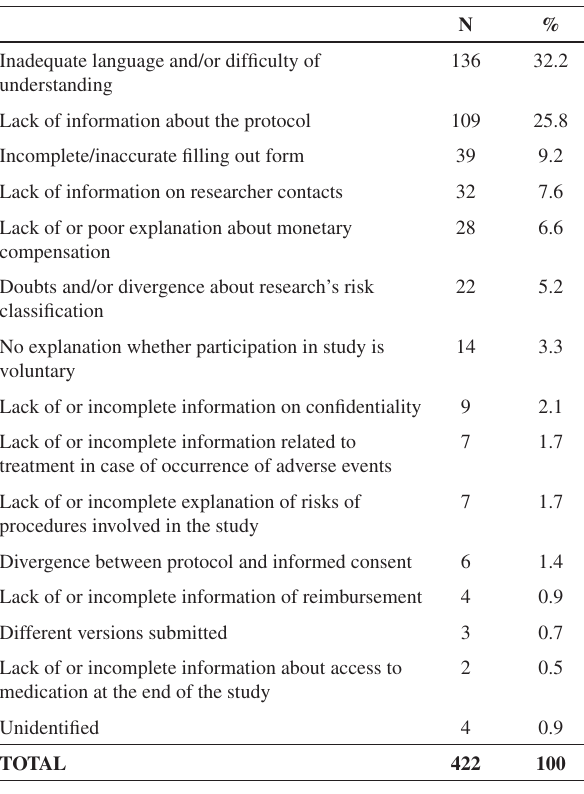
Table 4 - Protocol-related reasons for returning